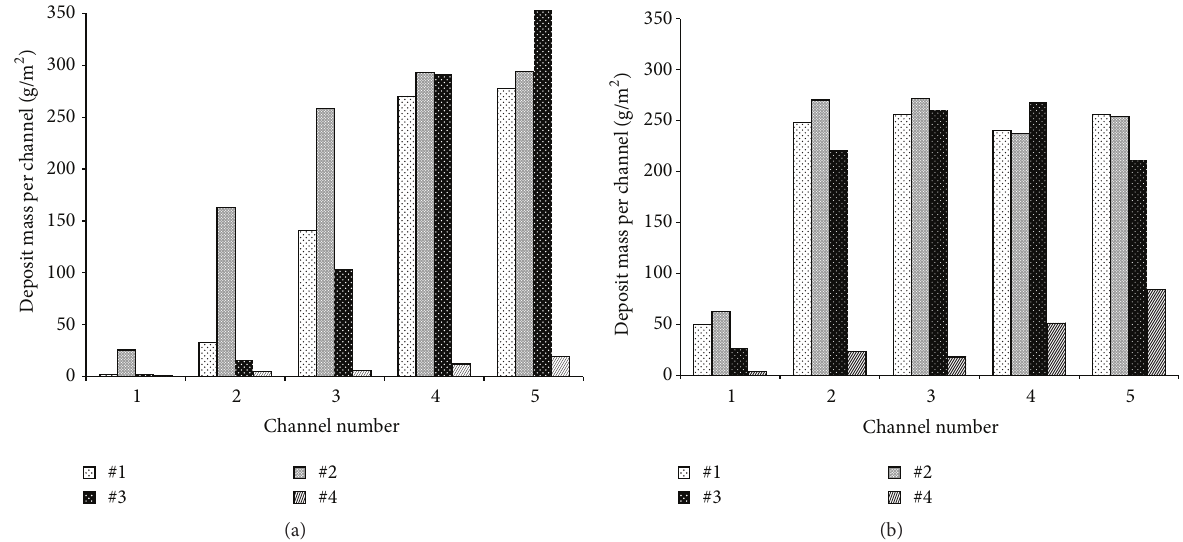
Figure 7: Fouling mass distribution, related to the projected heat transfer area per plaque, in each channel of the PHE for the two fouling solutions. 1% (w/w) WPI solution containing (a) 100ppm calcium and (b) 120ppm calcium (# 𝑖 corresponds to the thermal profile number given in Figure 4 and Table 2).